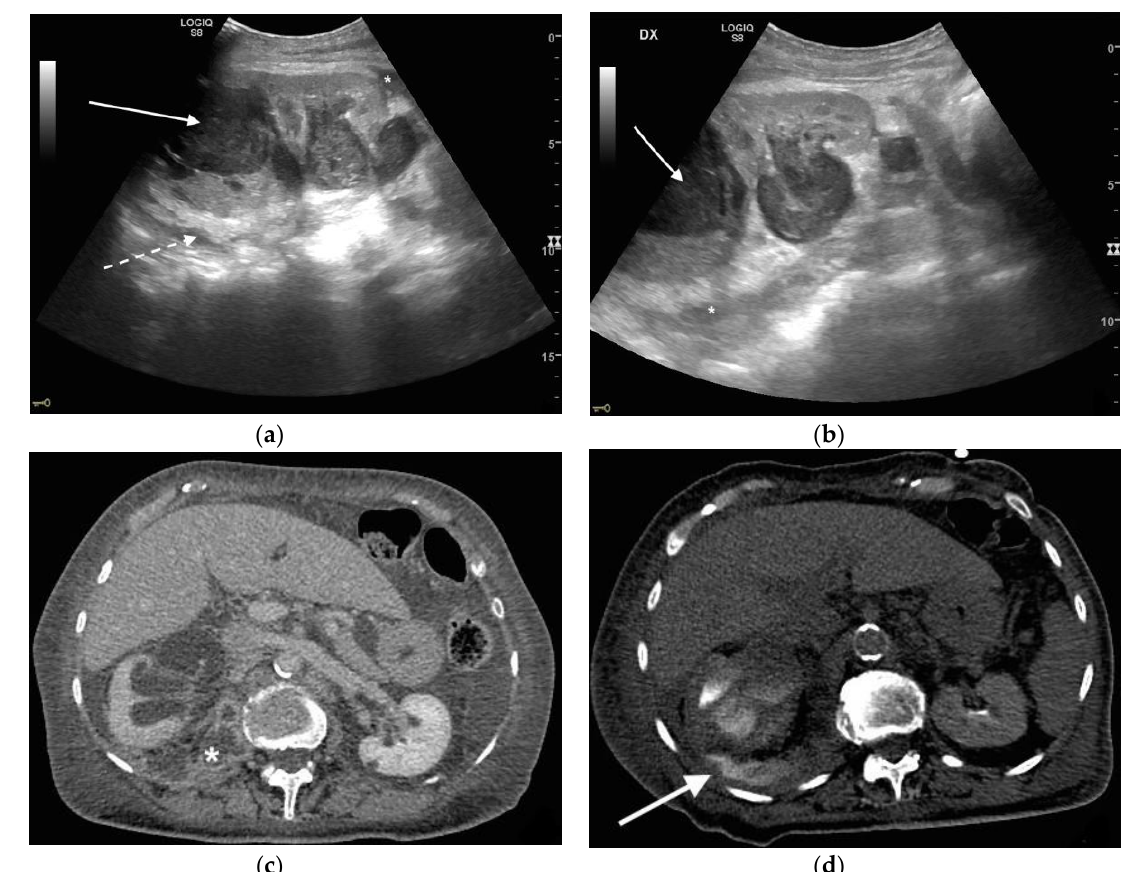
Figure 6. An 83 y/o septic woman. US longitudinal ( a , b ) view of the right kidney showing high-grade hydronephrosis with the calyceal-pelvic system completely occupied by inhomogeneous echogenic debris (with arrow). Perirenal fascia is thickened and perirenal fat is hyperechogenic and inhomogeneous (dashed arrow). Fluid over-collection is appreciated around the kidney (*), and free fluid was appreciated in the abdomen. Complicated pyonephrosis with extrarenal extension was diagnosed. CT with intravenous contrast. Axial CT after intravenous contrast in parenchymal ( c ) and urography phase ( d ), showing hydronephrosis with parietal thickening of calyceal-pelvic system, multiple loculated over fluid collection in the perirenal (white arrow) space and abscess in iliopsoas muscle (*). In the urography phase, extravasation of urine into extrarenal fluid collections due to abscessualization of the calyceal-pelvic system.